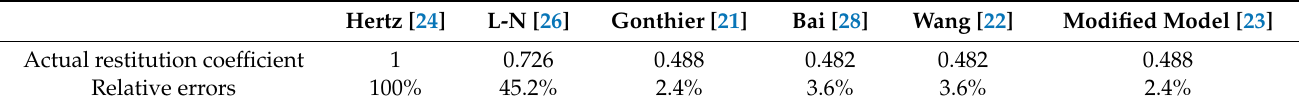
Table 2. Relative errors of the restitution